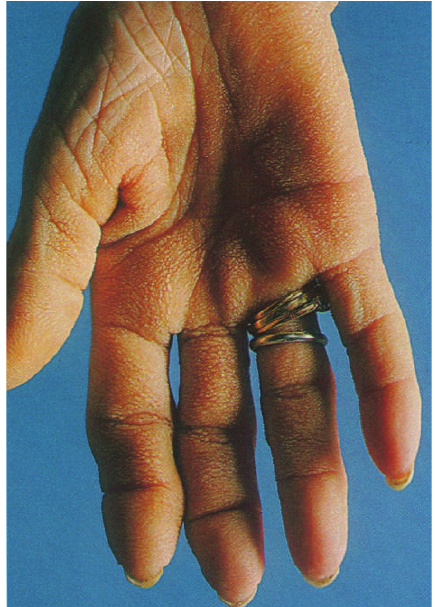
Figure 8: Acanthosis nigricans [9, page 502].